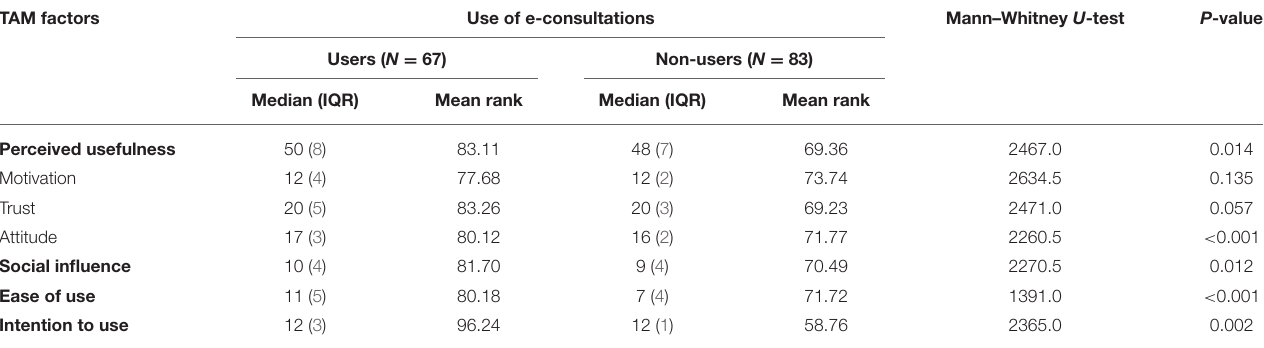
TABLE 4 | TAM factors influencing the use of e-consultations among actual users and non-users. TAM